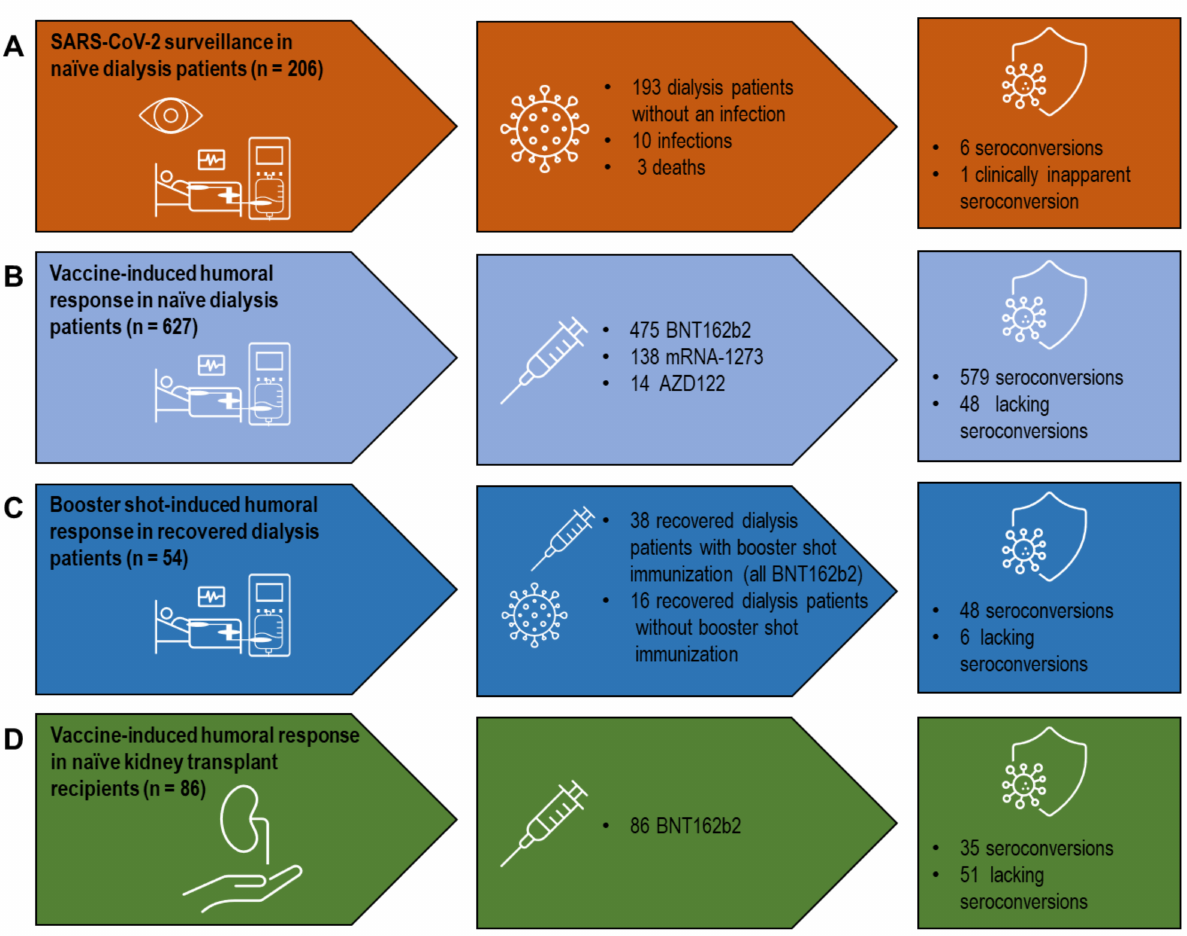
Figure 1. A systematic analysis of vaccine- and infection-induced humoral SARS-CoV-2 immune responses in dialysis patients and kidney transplant recipients. ( A ) SARS-CoV-2 surveillance in SARS- CoV-2-naïve dialysis patients. ( B ) Vaccine-induced humoral response in SARS-CoV-2-naïve dialysis patients. ( C ) Booster shot-induced humoral response in SARS-CoV-2 convalescent dialysis patients. ( D ) Vaccine-induced humoral response in SARS-CoV-2-naïve kidney transplant recipients. Vaccines used: BNT162b2 (BioNTech/Pfizer, Mainz, Germany/New York, NY, USA), mRNA-1273 (Moderna, CA, USA), AZD1222 (AstraZeneca/University of Oxford, Cambridge/Oxford, UK). SARS-CoV-2: severe acute respiratory syndrome coronavirus type